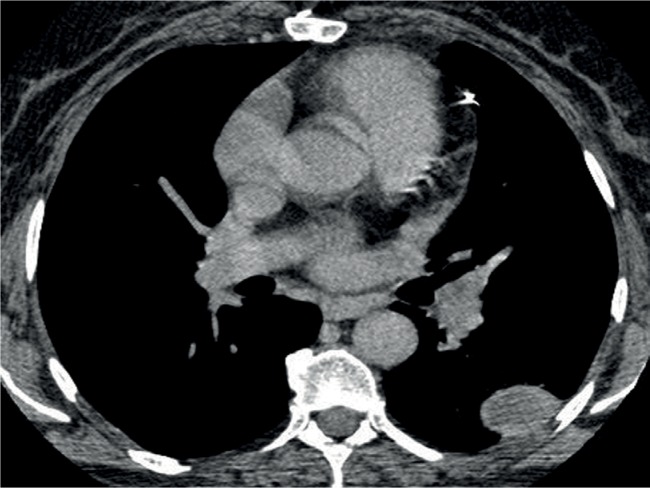
TC de tórax, corte axial, com janela para o mediastino e contraste
intravenoso. Presença de massa de contorno regular, com limites bem
definidos, impregnação periférica pelo meio de contraste, em íntimo
contato com a superfície pleural, localizada posteriormente no terço
médio do hemitórax esquerdo.